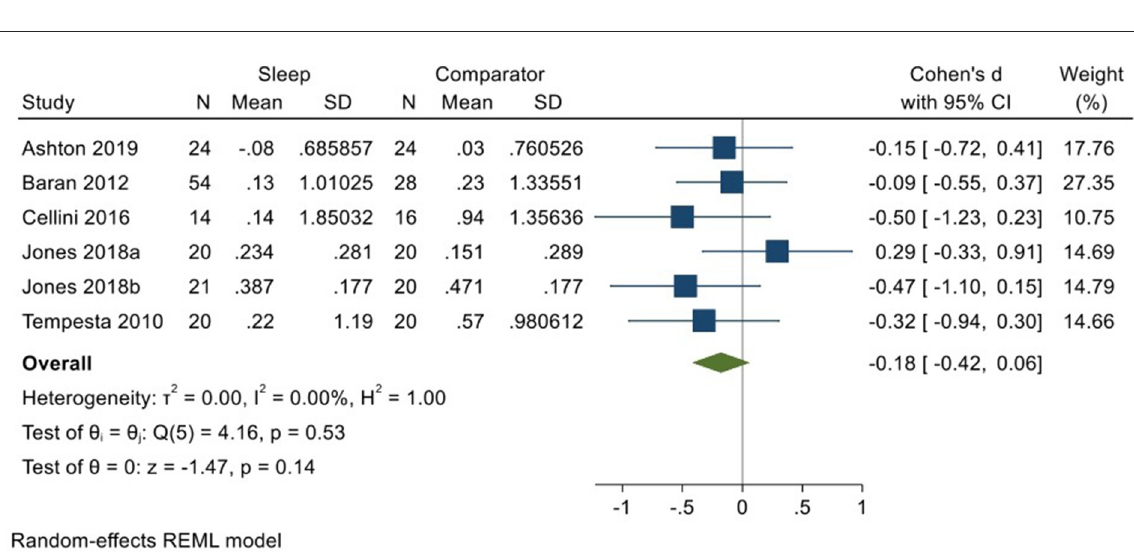
vs. nap), and whether participants experienced REM sleep